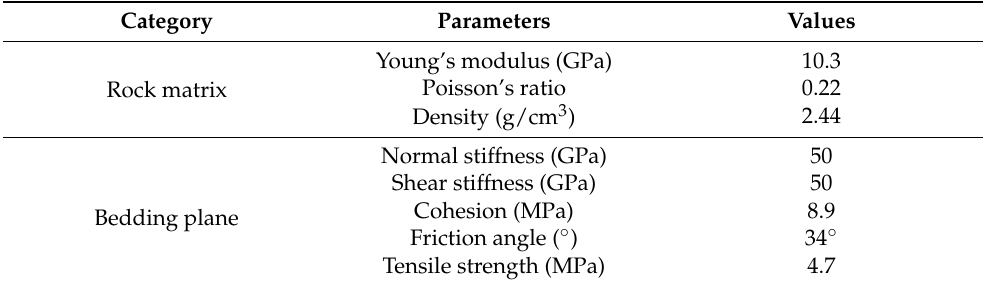
Figure 5. Numerical model used for hydraulic fracturing simulations: ( a ) 3D bedding model with an edge length of 10 m; ( b ) x-z plane with y = 10 m cut from the bedding model. Table 1. Property settings in the simulations [11,56].